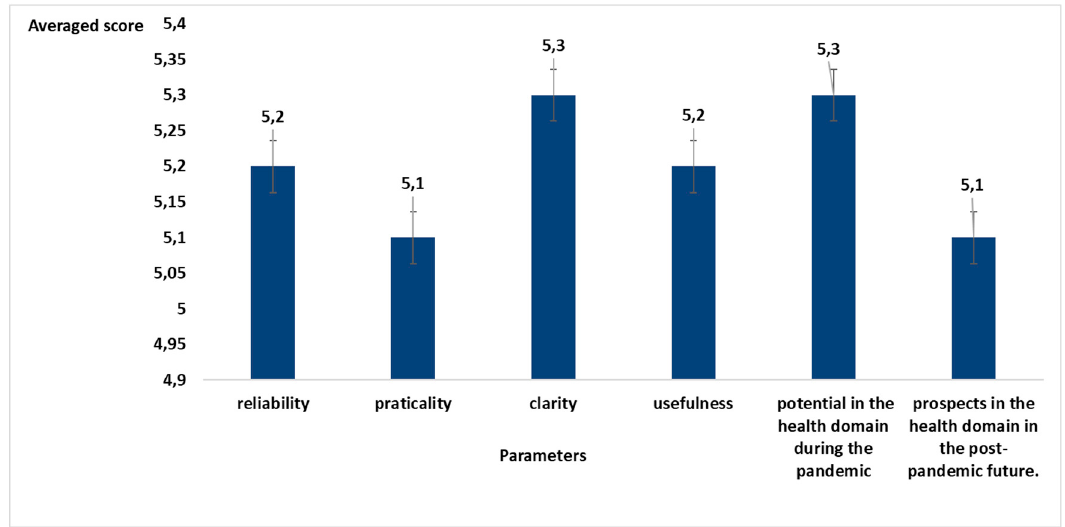
Figure 4. Average score for the different parameters proposed to assess the opinion of the